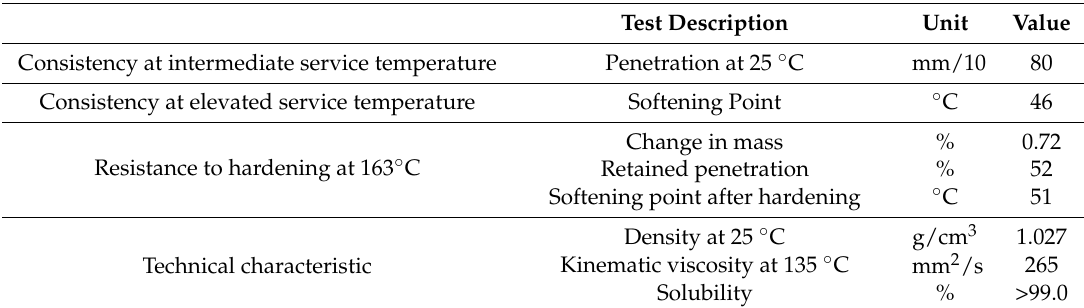
Table 1. Specifications of Nynas 70/100.